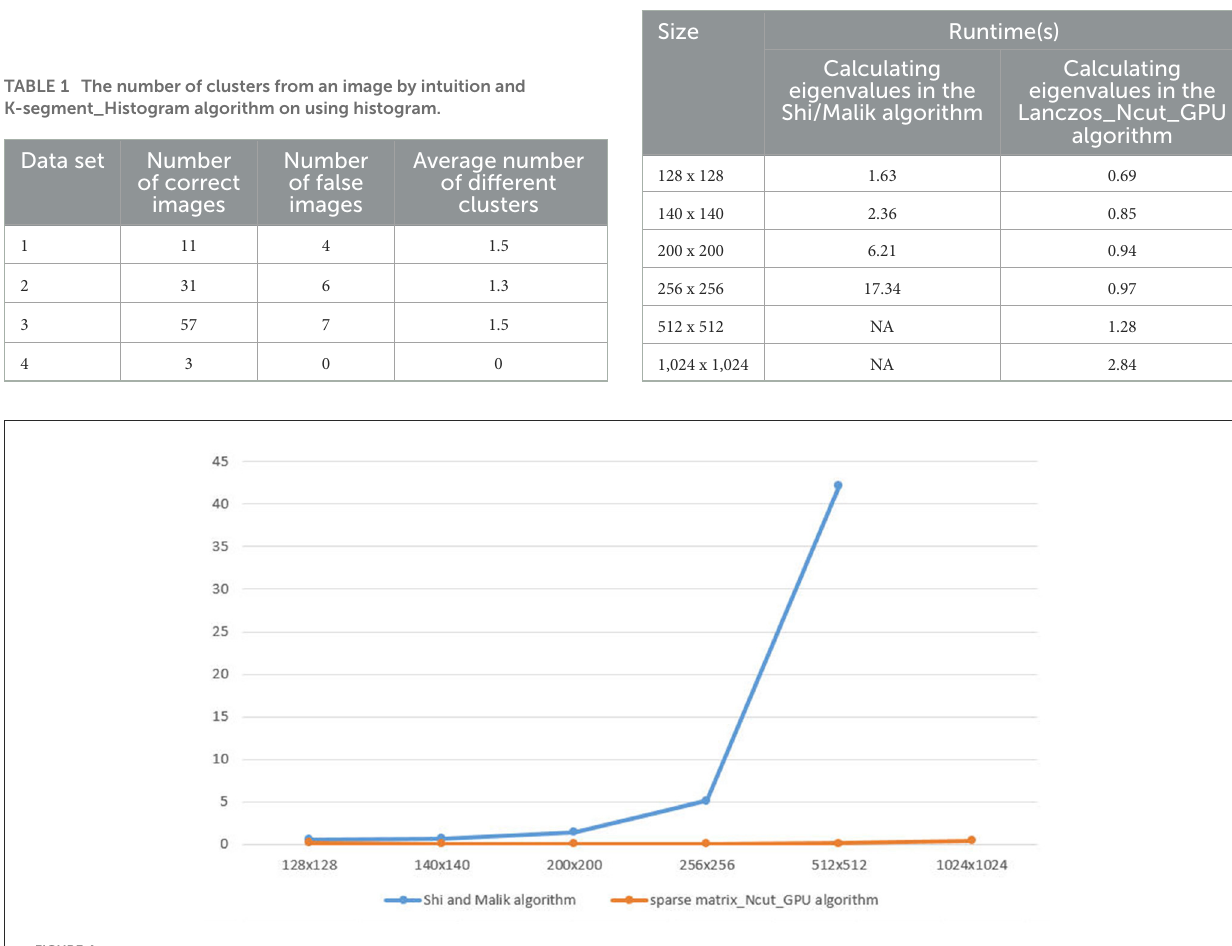
FIGURE4 The speed time between Shi/Malik algorithm and sparse matrix_Ncut_GPU algorithm.